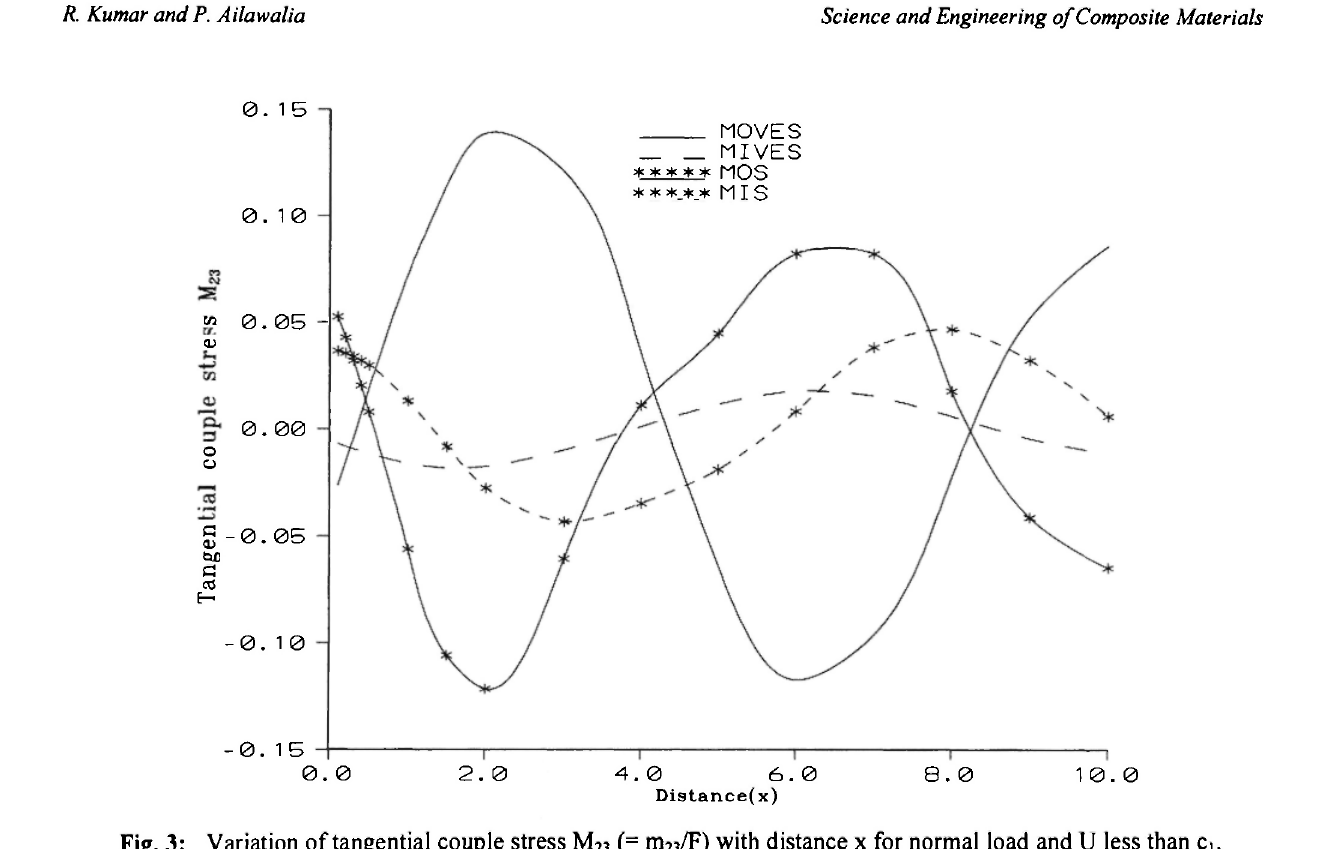
Variation of tangential couple stress M 2 3 (= m 23 /F) with distance χ for normal load and U less than c,.